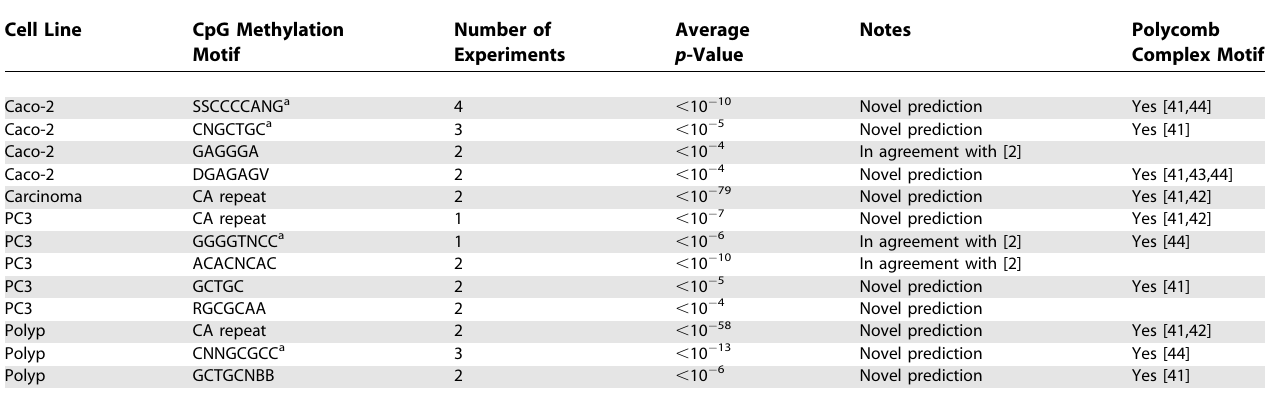
Table 1. Enriched Motifs Associated with CpG Methylation in Four Human Cancer Cell Lines and Comparison to Motifs in Regions Bound by the Polycomb